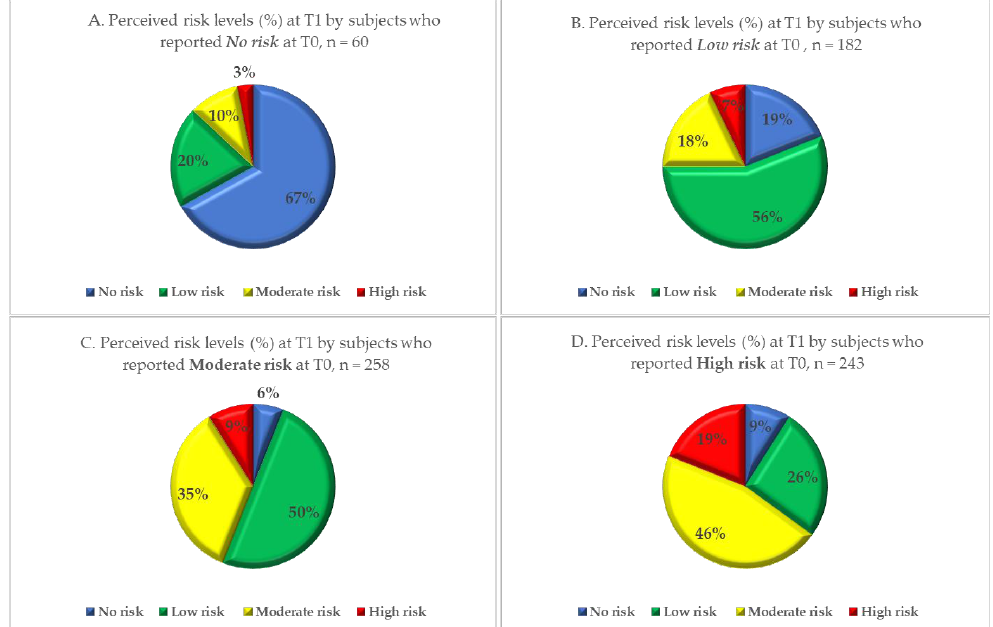
Figure 2. Level of perceived risk after among parents ( n = 743) with no (Quadrant. A), low (Quadrant. B), moderate (Quadrant. C) and high (Quadrant. D) perceived risk at baseline, after the local health authority intervention.